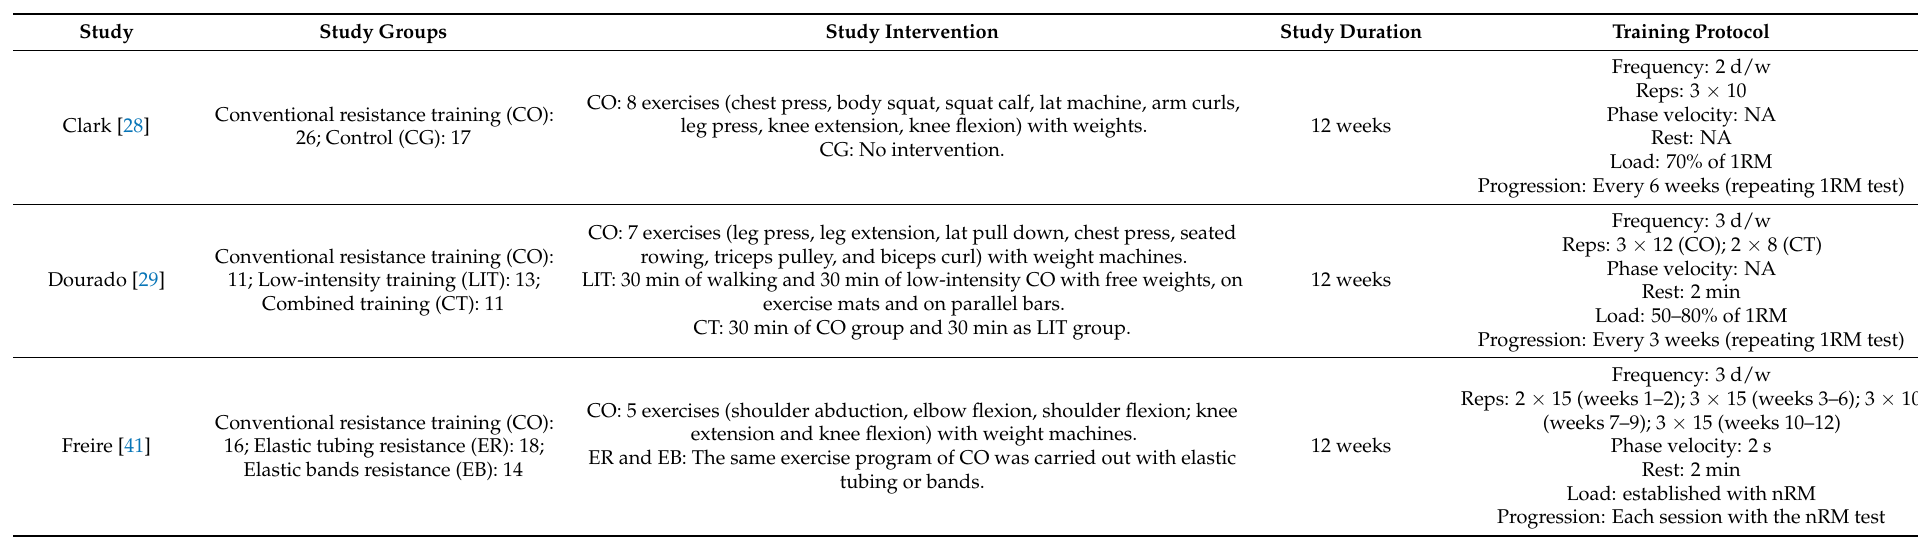
Table 2. Characteristics of the included